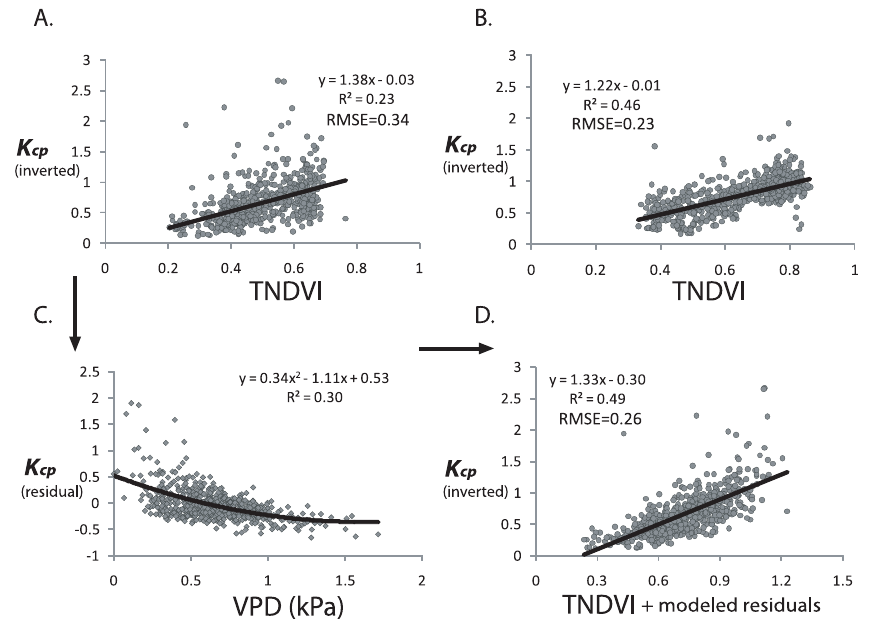
Fig. 1. Derivation of the phenological factor in evapotranspiration ( K cp ) from TNDVI. (A) K cp -TNDVI relationship in grassland. (B) K cp -TNDVI relationship in cropland. (C) Modeling K cp residuals in grassland. (D) Relationship between observed and TNDVI in grassland with modeled residuals added.